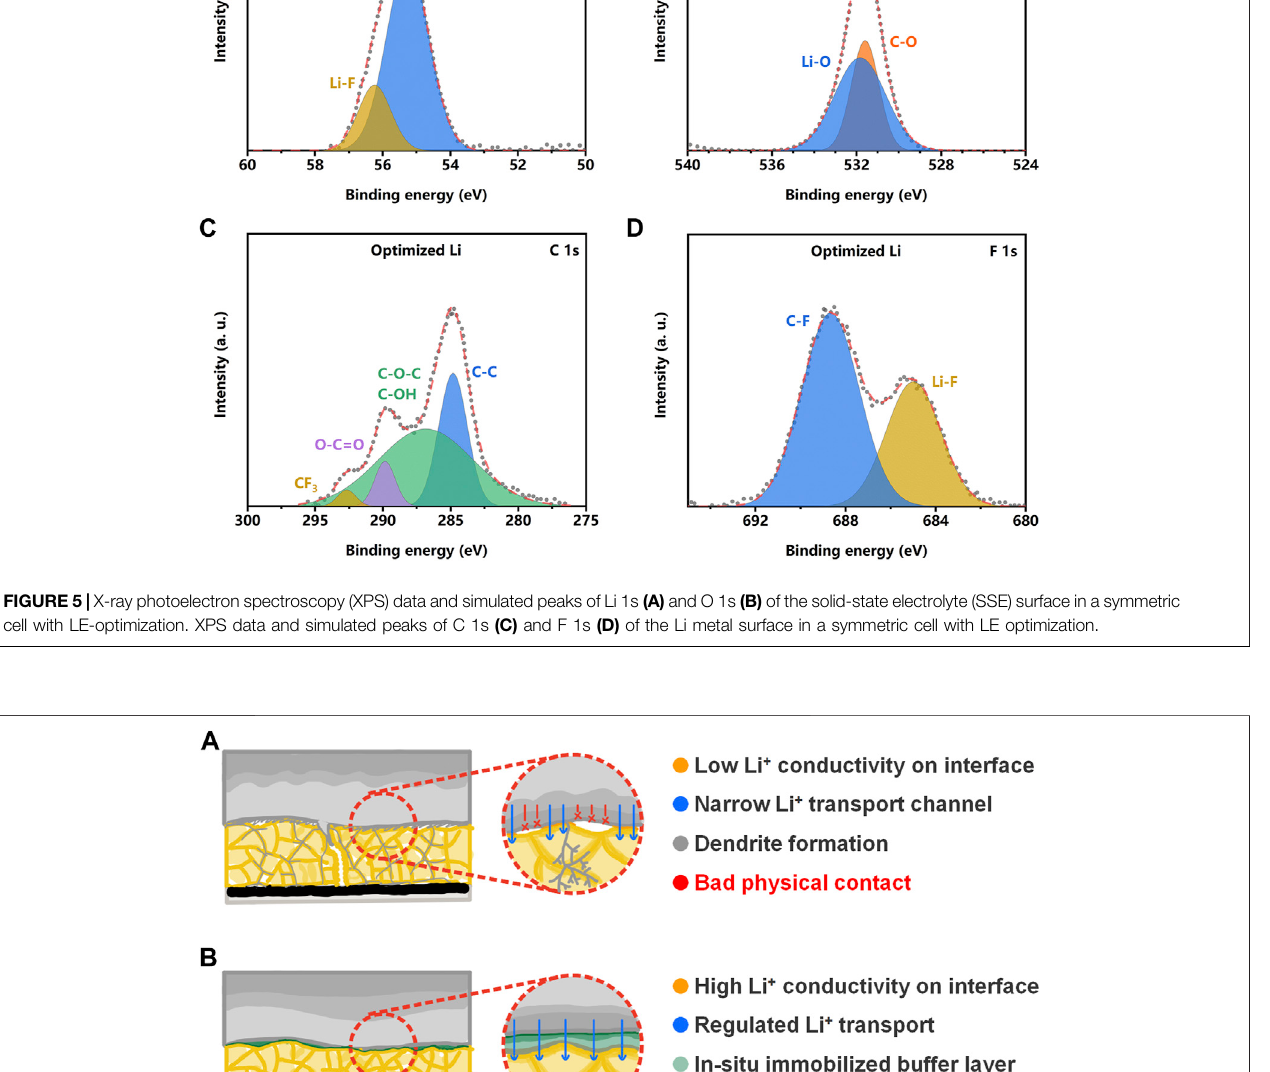
(B) Schematic illustrating the improved 2 OHCl SSE pellet.